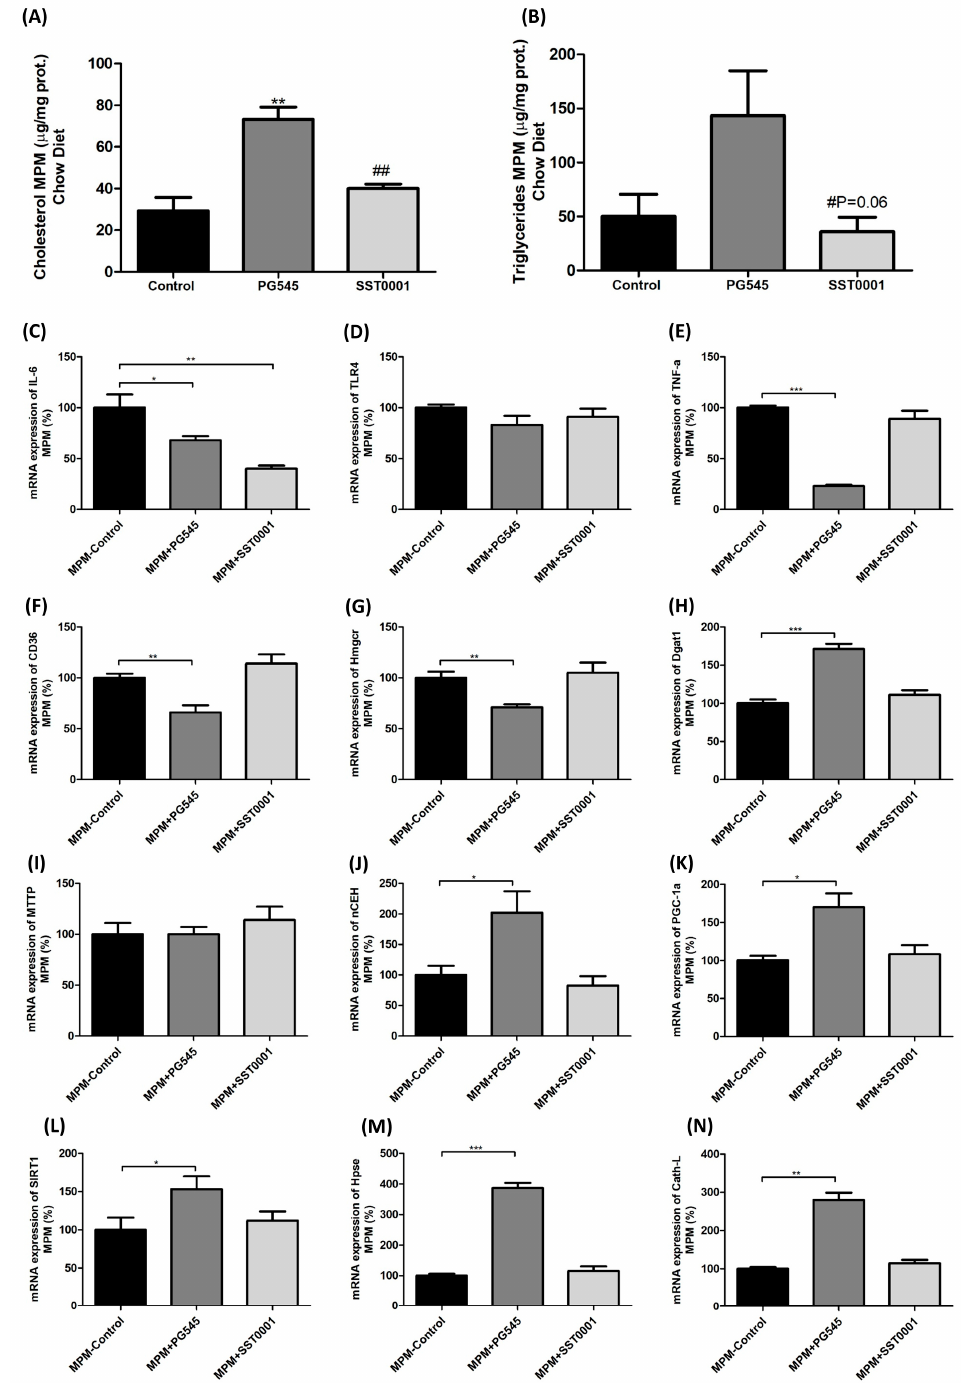
Figure 6. Effect of heparanase inhibitors on macrophage lipid uptake and inflammation (in vitro). TC and TG content ( A , B ), mRNA expression of inflammation markers ( C – E ) and lipid uptake and metabolism markers ( F – N ). (*) as compared to Control. (#) as compared to PG545. * p < 0.05, ** p < 0.01, *** p < 0.001. # p < 0.05, ## p < 0.01.